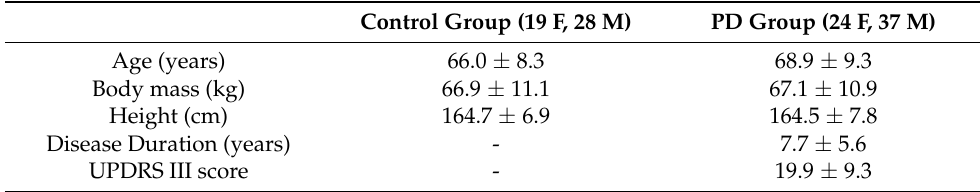
Table 1. Demographic, anthropometric, and clinical characteristics of participants. Values are expressed as mean ± SD.